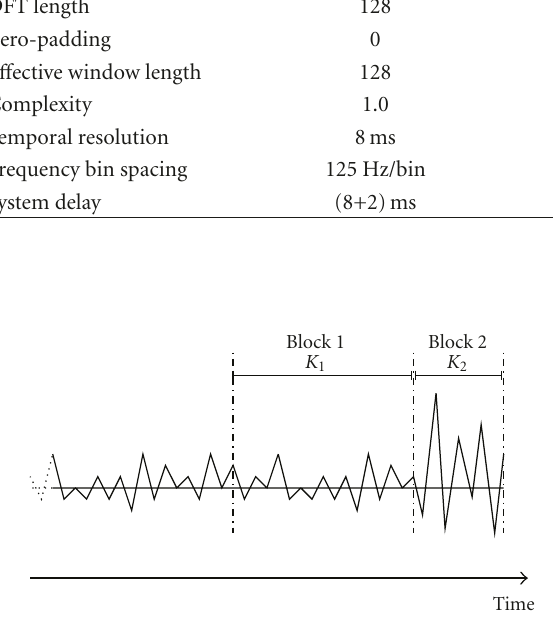
Figure 4: Definition of blocks 1 and 2, consisting of K 1 and K 2 samples,